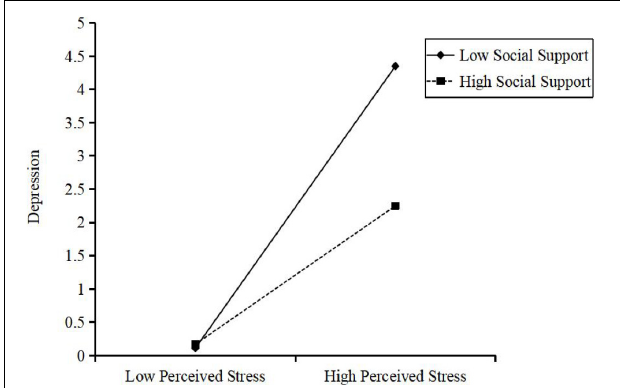
FIGURE 4 | Interaction effect of social support and perceived stress on the depression symptom. High and low levels of perceived stress and social support represent one standard deviation above and below the mean,